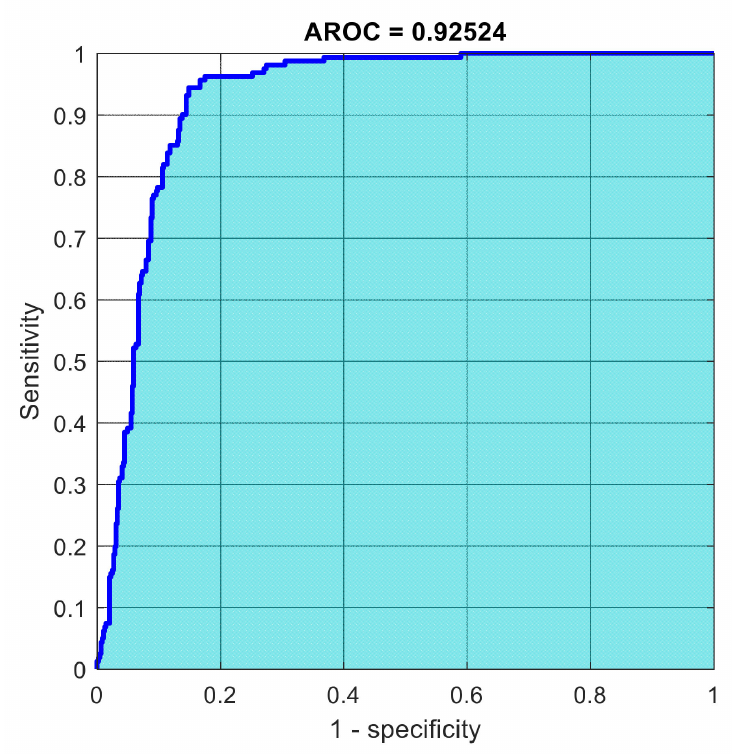
Figure 15. The AROC with ECFS-reduced features for the whole cascading